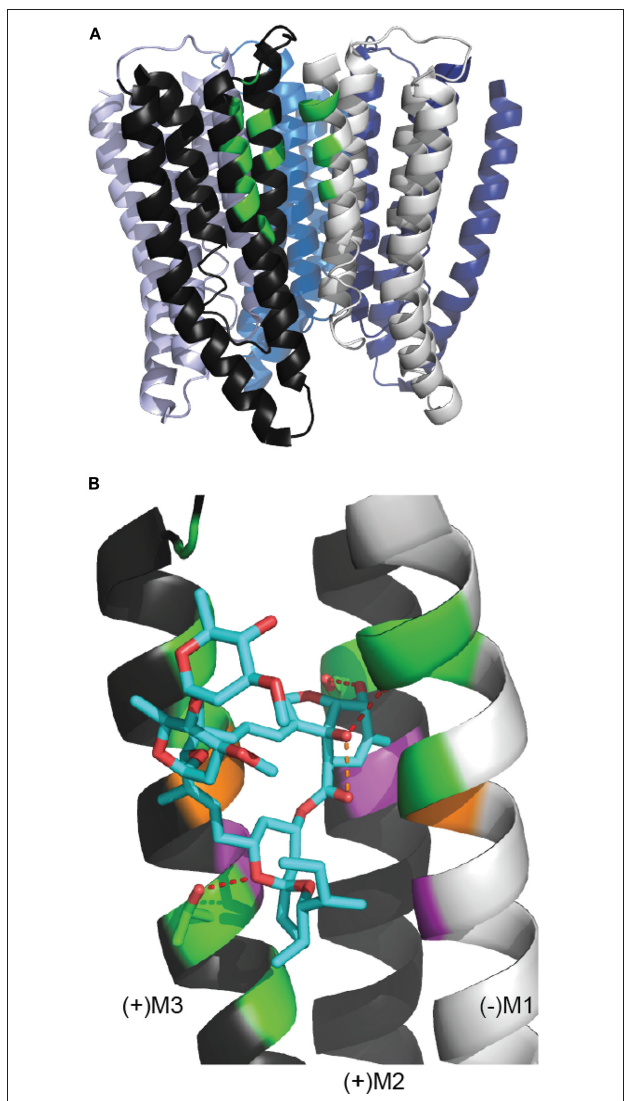
FIGURE 2 | The ivermectin binding site in the C. elegans α GluClR crystal structure. (A) The GluClR pentamer viewed from within the membrane plane, with ECDs removed for clarity. At one subunit interface, the residues that contact the bound ivermectin molecule are indicated in green, showing that ivermectin binds to the receptor in the outer half of the membrane. (B) Ivermectin (blue) bound to a subunit interface. Ivermectin forms hydrogen bonds (red dashed lines) with ( + )M3 threonine 285, ( + )M2serine 15 (cid:2) and the backbone carbonyl oxygen of ( − )M1 leucine 218 (Hibbs and Gouaux, 2011). The orange dashed line indicates the 2.6 Å proximity of the C7 hydroxyl oxygen and the C1 carbonyl oxygen of ivermectin. Green indicates residues proximal to ivermectin, indicative of hydrogen bonds or van der Waals interactions. Purple indicates residues equivalent to those in the α 1 GlyR (GlyR M3 leucine 291, M2 threonine 12 (cid:2) , M1 leucine 233) whose substitution by tryptophan causes ivermectin to act as an inhbitor (Lynagh et al., 2011). Orange indicates residues (GluClR ( + )M3 glycine 285 and ( − )M1 223) that contribute van der Waals interactions in the GluClR and whose substitution for larger residues decreases ivermectin sensitivity in the α 1 GlyR (the ( − )M1 residue) or in both α 1 GlyR and the H. contortus α 3B GluCl (the ( + )M3 residue) (Lynagh and Lynch, 2010b; Lynagh et al., 2011). This figure uses the same PDB file and software as Figure 1